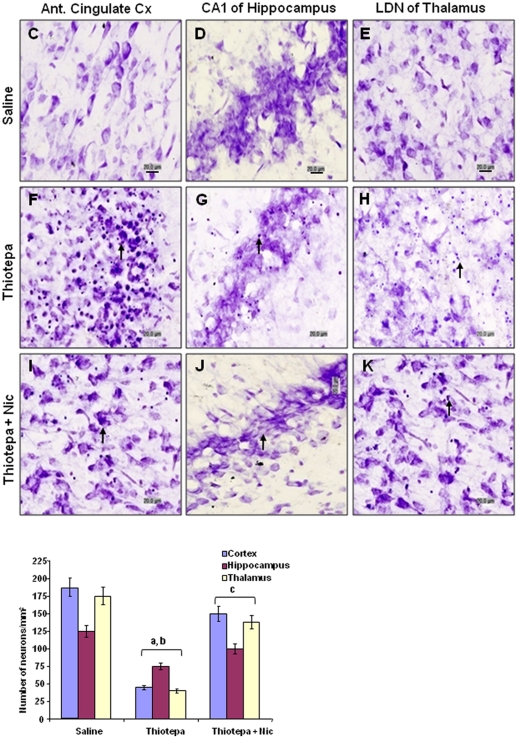
Co-treatment effect of nicotinamide on thiotepa-induced neuronal cell death.Light micrographs of cresyl violet-stained neurons in tissue sections of developing rat brain after thiotepa with nicotinamide. The majority of thiotepa-induced degenerating neuronal cells (generally shrunken in appearance, as is commonly observed) are present in the anterior cingulate cortex, CA1 of hippocampus and LDN of thalamus (F, G, and H). The arrows indicate shrunken and damaged neurons. Almost complete protection was observed (I, J and K), when nicotinamide was administered with thiotepa. Images are representative of staining obtained in sections (3–5/group) prepared from at least 5–6 animals/group. (C–K) of Nissl-stained brain tissue at higher magnification with 40× objective field, Scale bar = 20 µm. Statistical difference was determined using one-way analysis of variance (ANOVA) followed by Student's t-test. (aSignificantly different from CTL, [cortex P<0.001, hippocampus P<0.05 and thalamus P<0.001]; bSignificantly different from Thiotepa + Nicotinamide, [cortex P<0.01, hippocampus P<0.05 and thalamus P<0.01]; cSignificantly different from Thiotepa, [cortex P<0.01, hippocampus P<0.05 and thalamus P<0.01]).